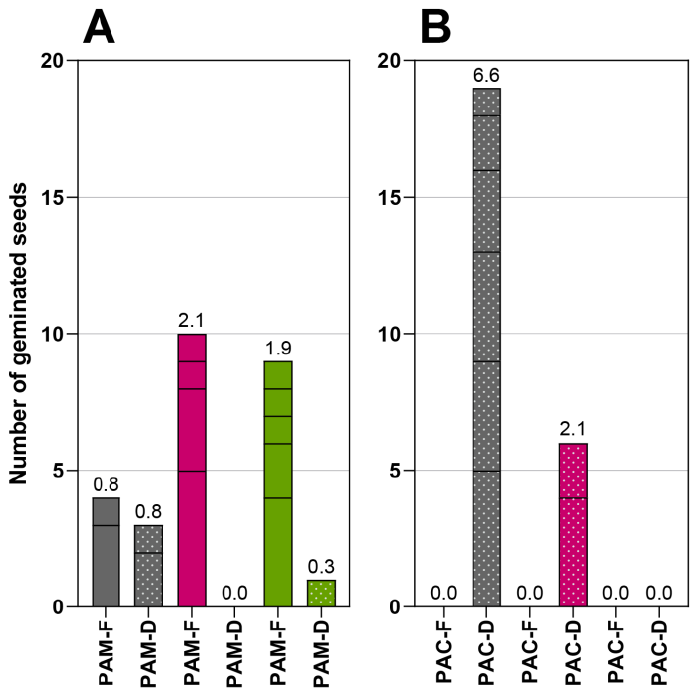
Figure 3. The number of germinated seeds from whole fruits of P. americana ( A ) and P. acinosa ( B ). The colours of the columns represent the colours of fruits. Solid columns mark fresh fruits (F) planted immediately after collection, and dotted columns mark dry fruits (D) planted 6 months after collection. The division lines within the columns indicate the number of germinated seeds that originated from the same fruit. The numbers above the columns show the percentage of germinated seeds.